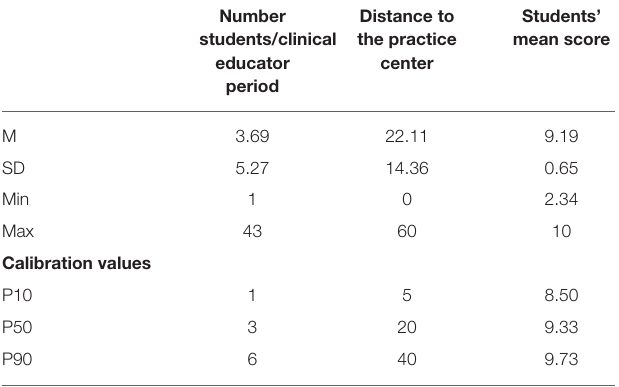
TABLE 2 | Main descriptions and calibration